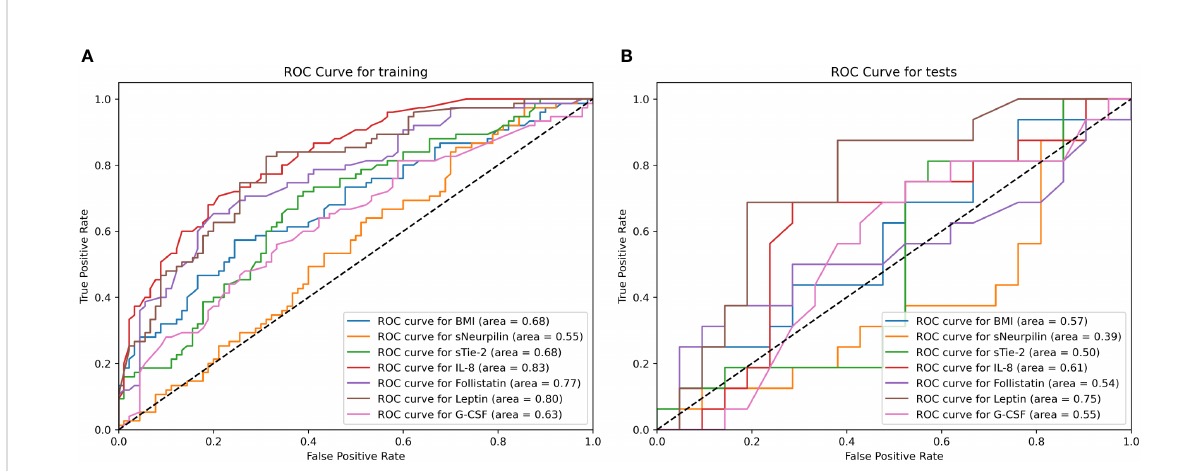
FIGURE 4 The Receiver Operating Characteristic (ROC) curve for all seven fi nal univariate models on the training (A) and test (B) dataset calculated using the cross-folding method, as described in Section 2.4. (A) The curve shows how the true positive rates of individual models change according to the false positive rate, by varying the detection threshold in the model. The AUC metric for each curve is displayed in the parentheses. As can be seen, all models except neurpilin-1 perform better than random chance on the training dataset and the models are able to discern between case and control group with an AUC ≥ 0.63. (B) The curve shows how the true positive rates of individual models change according to the false positive rate by varying the detection threshold in the model. The AUC metric for each curve is displayed in the parentheses. As seen from the curve, only leptin and IL-8 based models deviate from the random line, and as shown in the performance metrics, only leptin reaches a statistically signi fi cant accuracy at the optimal ROC point. This indicates that the models (with the exception of the mentioned ones) over fi t on the training